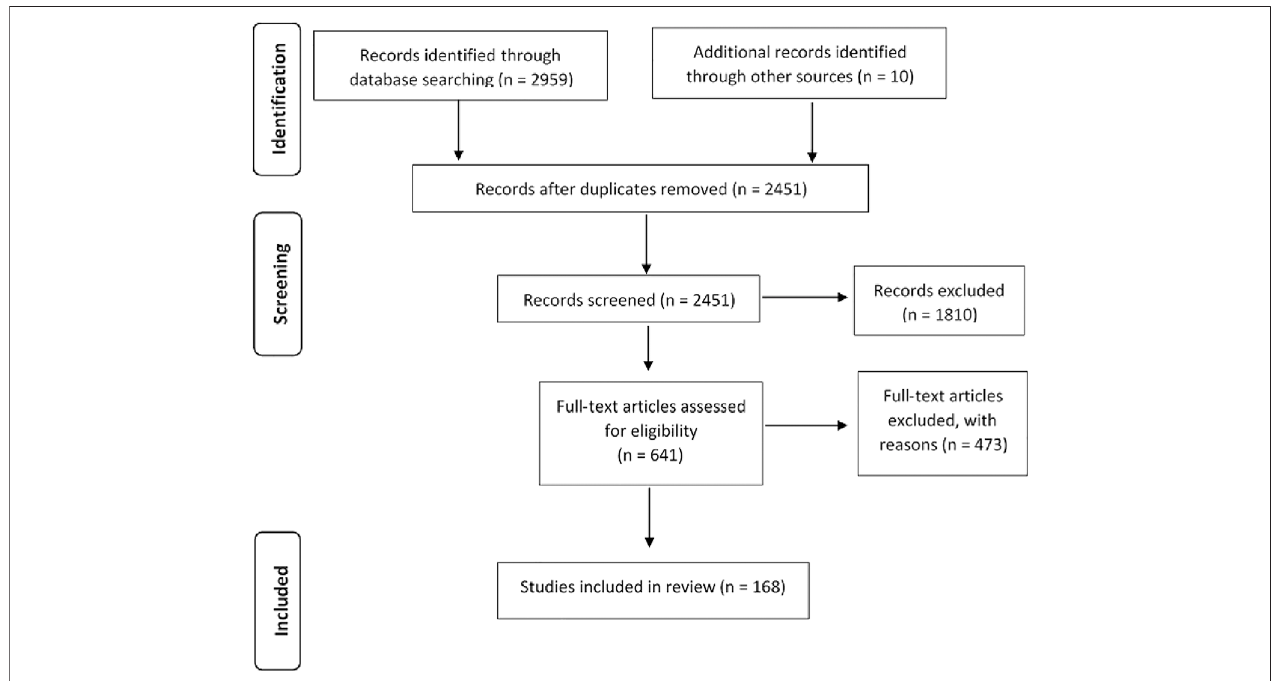
FIGURE 1 | Literature search fl ow on cognitive interventions.